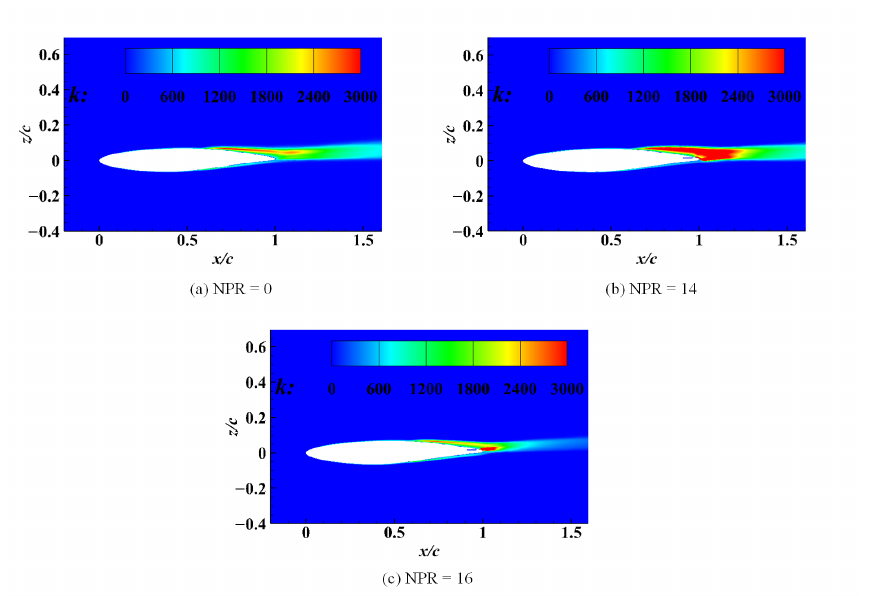
Figure 23. Entrainment characteristics with increase in NPR ( Ma =